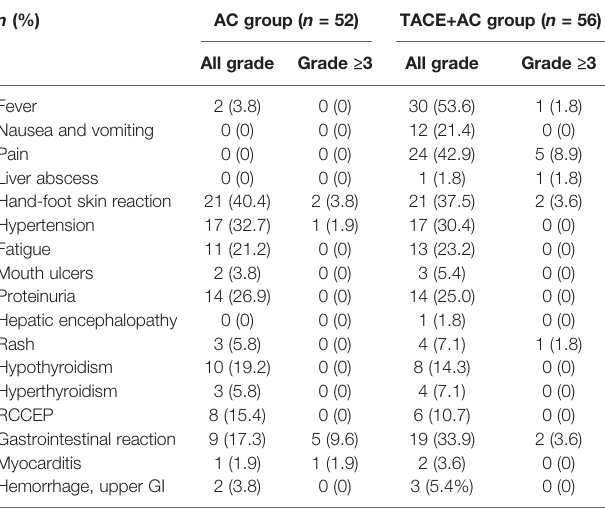
TABLE 4 | Treatment-related adverse